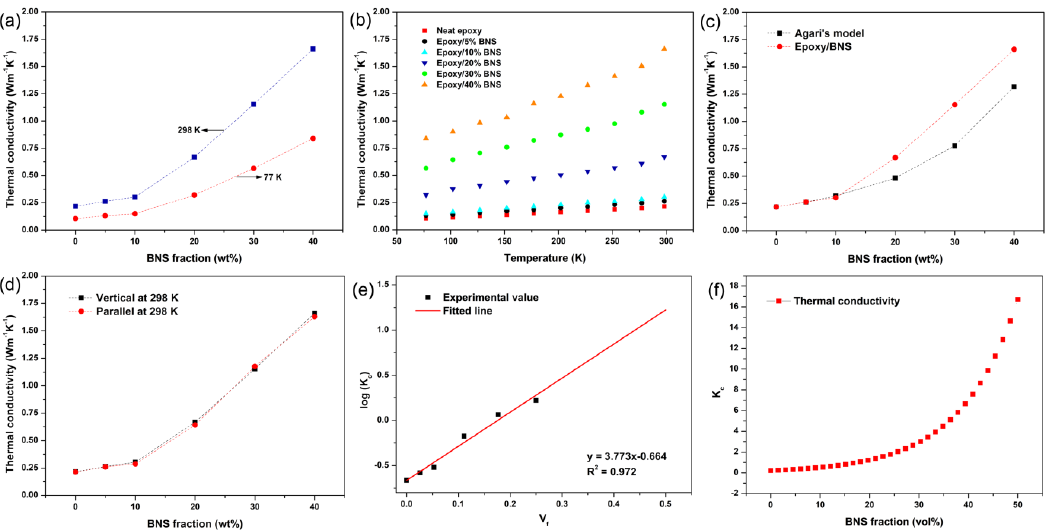
Figure 4. ( a ) Thermal conductivity of epoxy/BNS composites at 77 and 298 K. ( b ) Temperature-dependent thermal conductivity of epoxy/BNS composites. ( c ) Calculated thermal conductivity according to Agari’s model ( C 1 = 1, C 2 = 1) and measured values at 298 K. ( d ) Thermal conductivities from vertical and parallel curing directions of the composites at 298 K. ( e ) Experimental thermal conductivity and fitted line as a function of V f (volume fraction of fillers). ( f ) Thermal conductivity from fitted results.